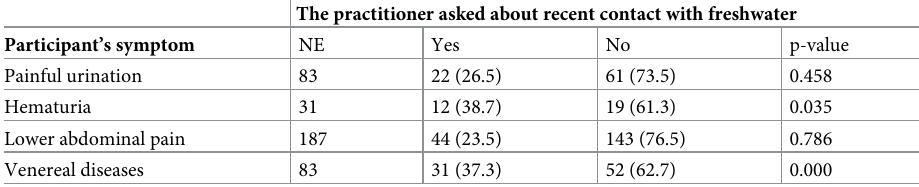
Table 5. Participants’ experiences during routine health care service on FGS-related